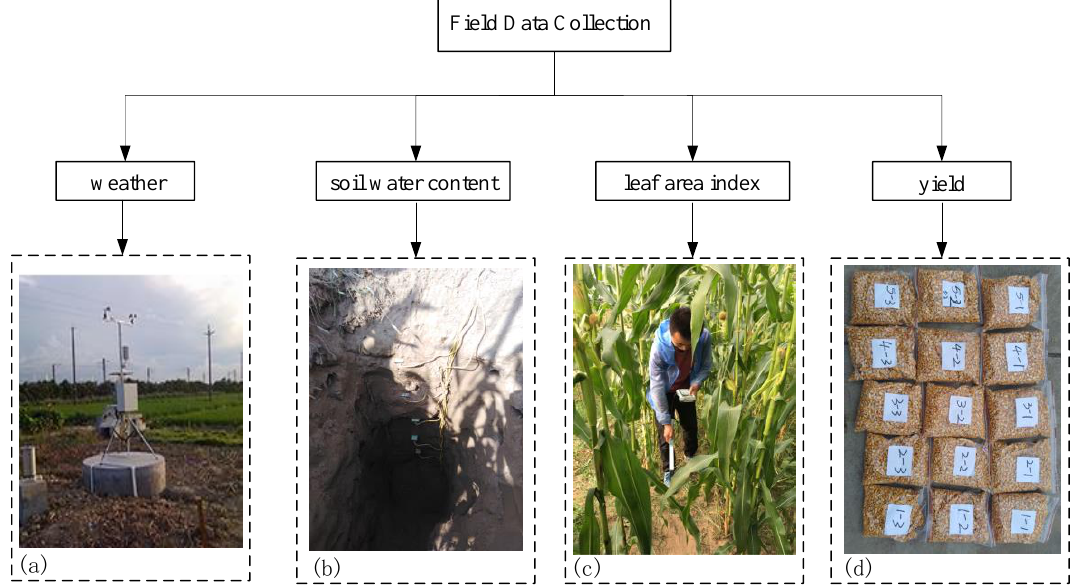
Figure 2. Schematic indicating the field data collection, including weather ( a ), soil water content ( b ), leaf area index ( c ), and yield ( d ).